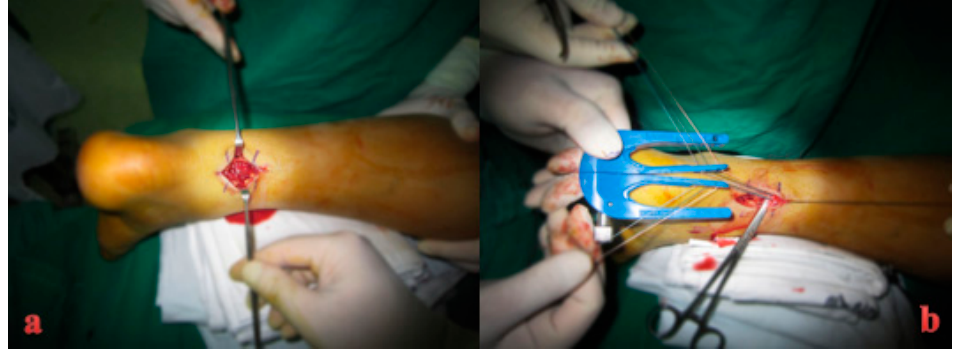
Figure 5. ( a ) Intraoperative finding of Achilles tendon rupture in the left ankle. ( b ) The Achillon ® instrument was introduced proximally under the paratenon, and three needles were passed.